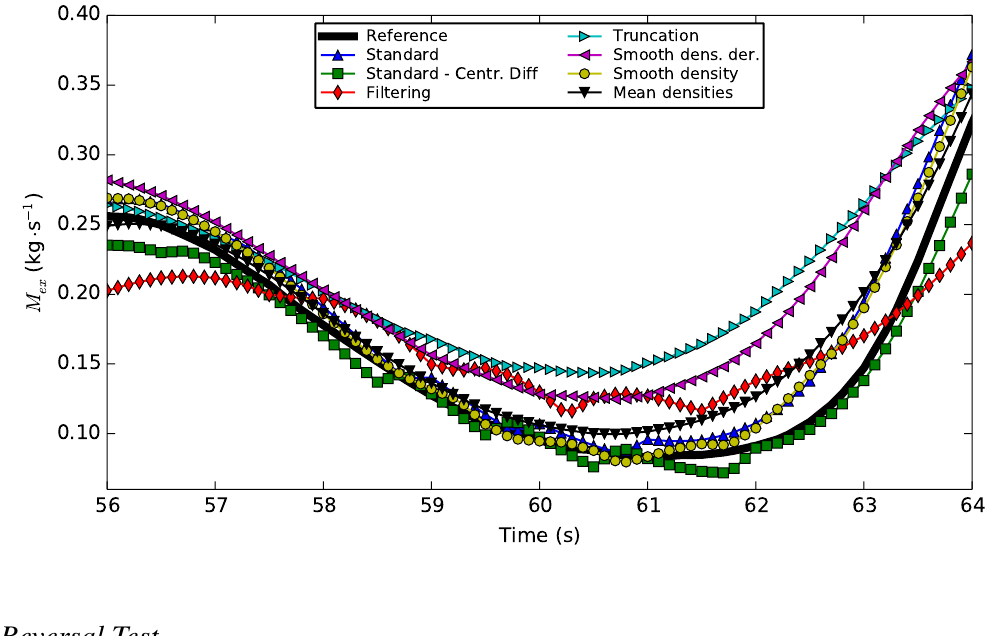
Figure 4. Sample of the simulation results with the different methods (when not specified, the upwind discretization scheme is